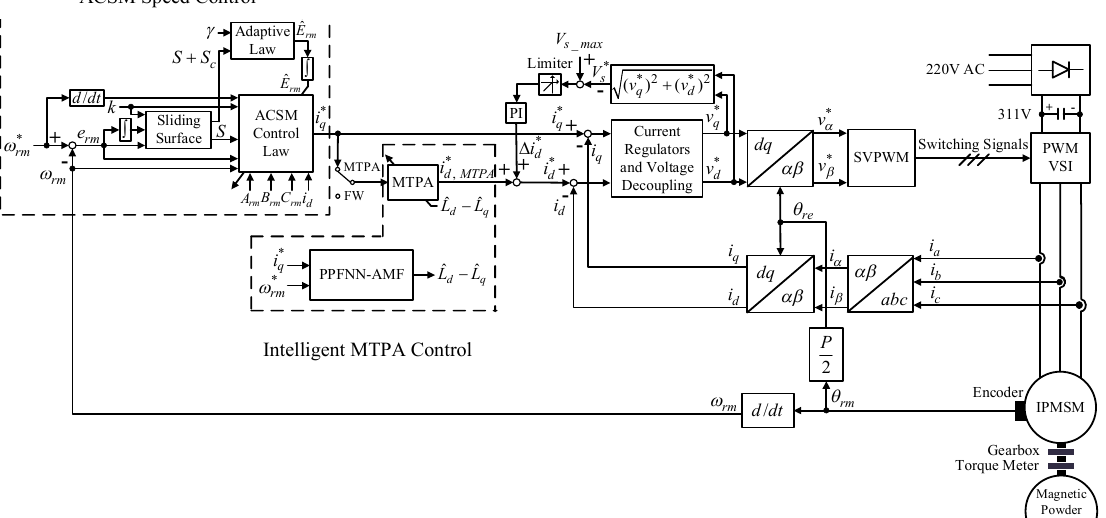
Figure 1. Block diagram of intelligent maximum torque per ampere (MTPA) and flux-weakening (FW)-controlled interior permanent magnet synchronous motor (IPMSM) drive system with adaptive complementary sliding mode (ACSM) speed controller.